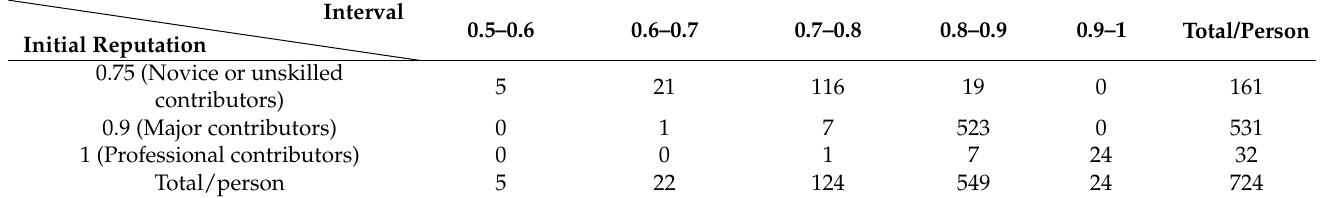
Table 2. Sample table of the relationship between contributor reputation and initial reputation.